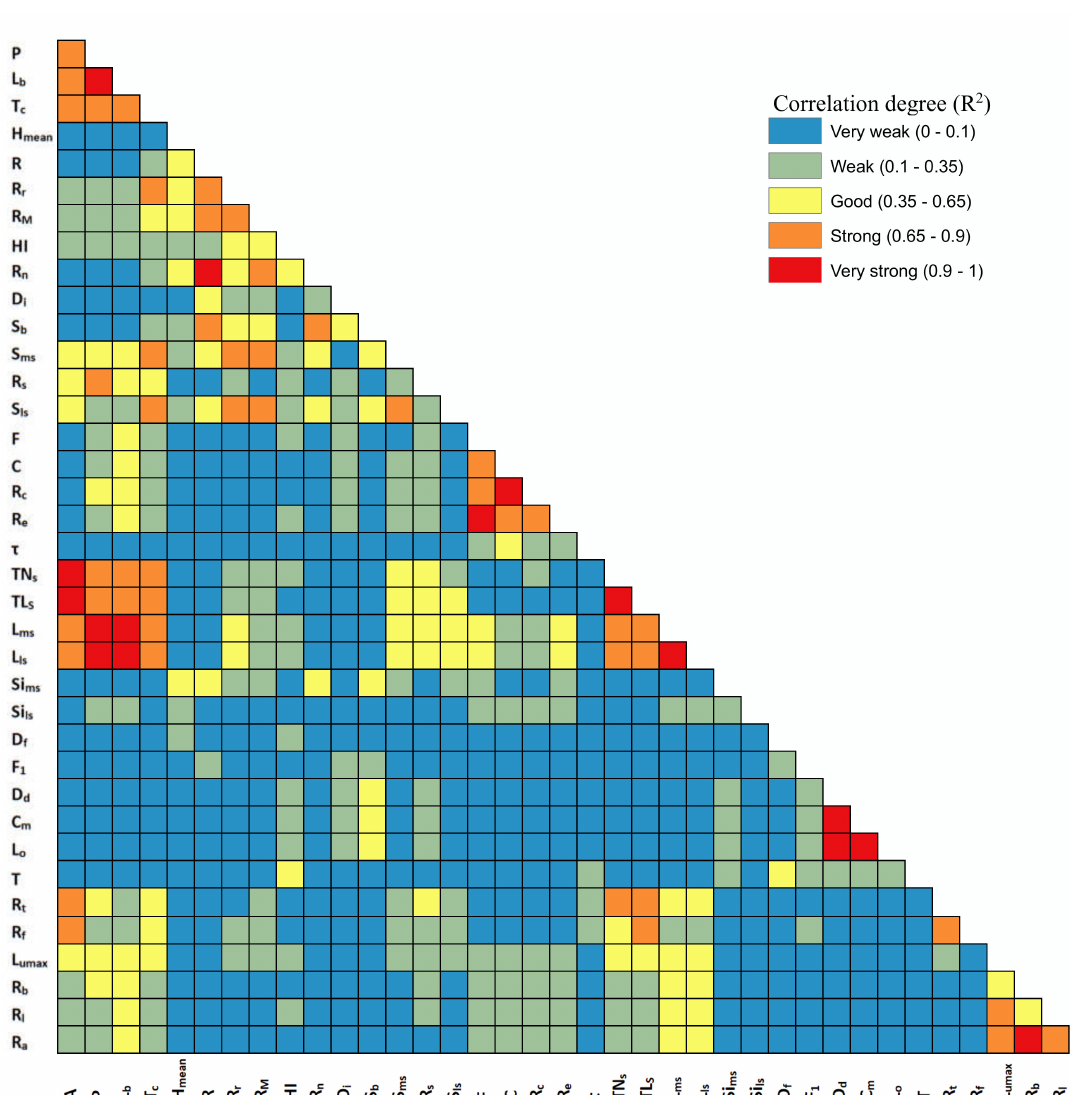
Figure 5. Correlation matrix between the assessed geomorphologic parameters based on R 2